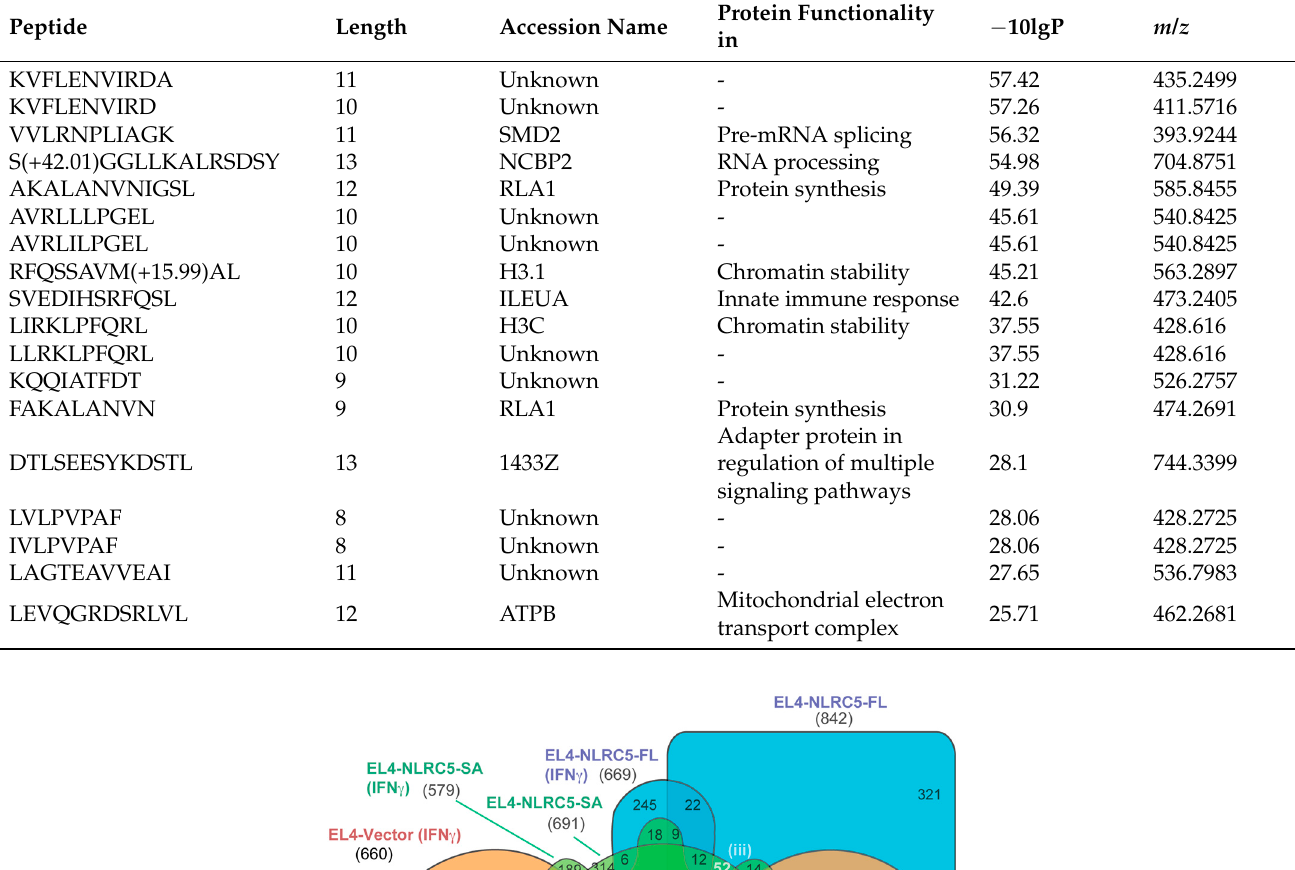
Table 2. Identity of the 18 peptides shared between NLRC5-FL- and NLRC5-SA-expressing EL4 cells in IFN γ -independent fashion. Numbers in brackets indicate the increase in aa mass due to post translational modification.